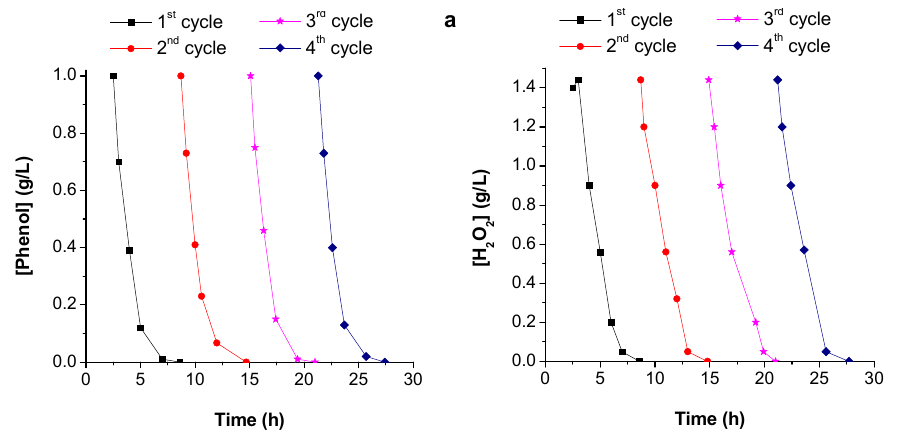
Figure 16. Evolution of phenol ( a ) and hydrogen peroxide ( b ) concentration during consecutive reuse cycles ([phenol] = 1 g/L, T = 50 °C, pH = 4.0, [Au/DNP] = 320 mg/L and [H 2 O 2 ] = 1.44 g/L). Adapted from Martín et al.[ 73].